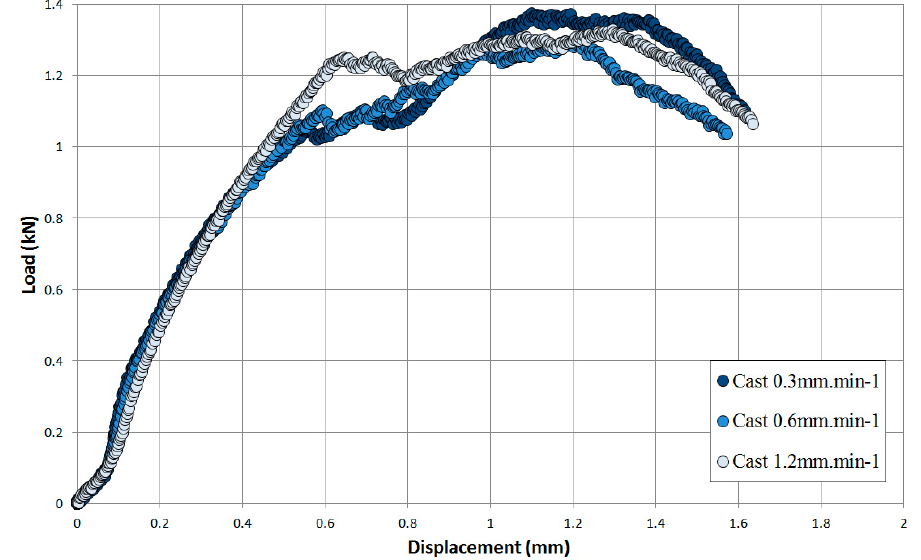
Figure 10. Effect of displacement rate on cast and HIP Ti-6Al-4V.